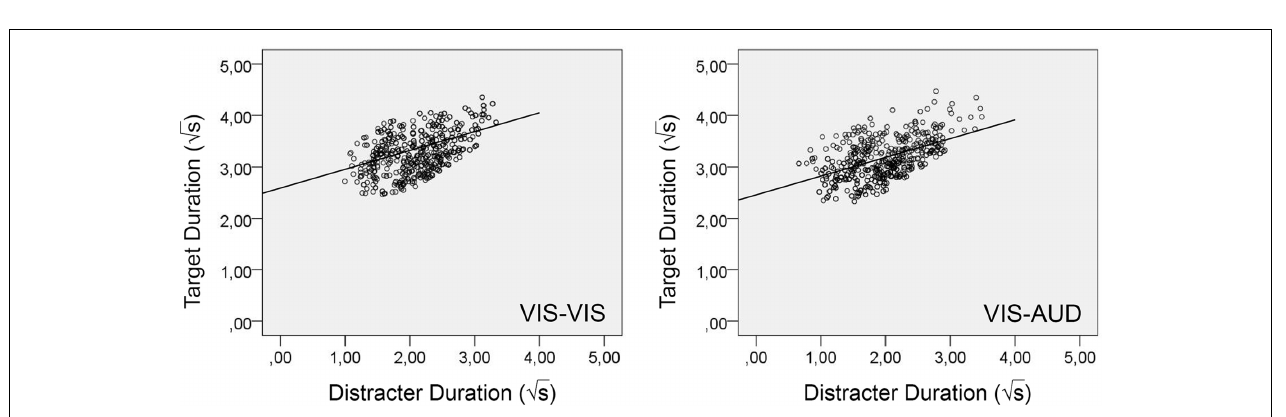
obtained from Experiment 1. Left panel: Data obtained from Condition VIS–VIS; Right panel: Data obtained from ConditionVIS–AUD.The straight line indicates the least-square regression